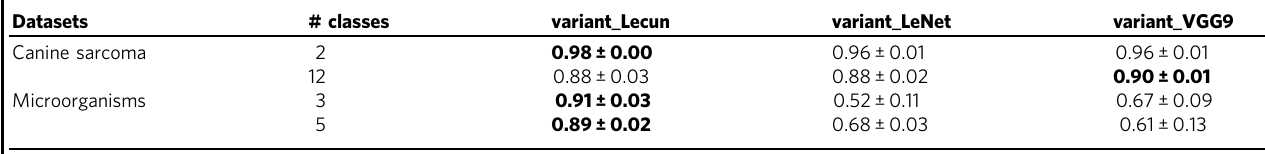
Table 1 Overall accuracies of SpiderMass spectra classi fi cation using three CNN architectures.